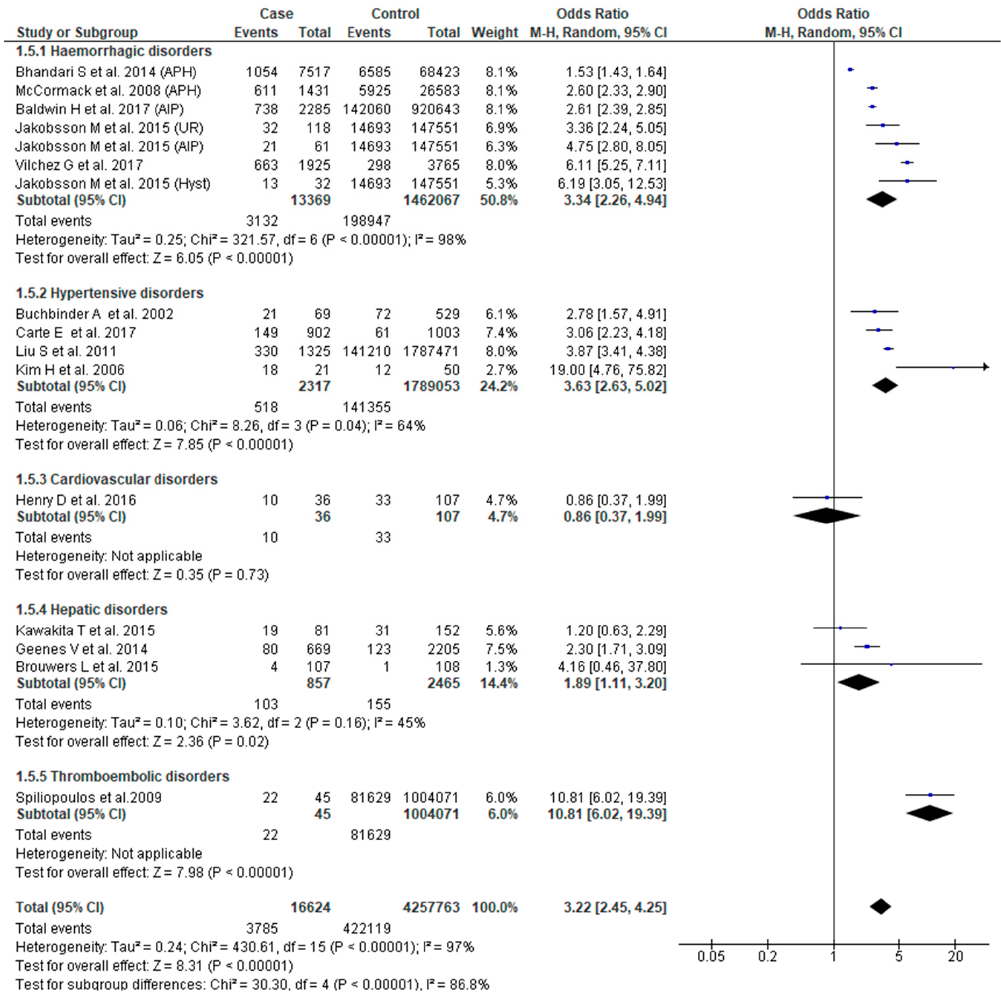
Figure 6. Forest plot of studies assessing association between Severe maternal morbidity (SMM) and neonatal intensive care unit (NICU) admission.